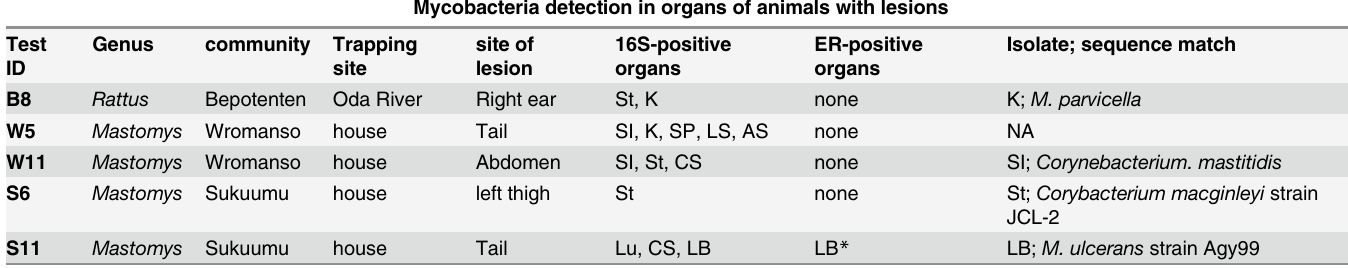
Table 4. Mycobacteria detection in organs of animals with lesions. Mycobacteria detection in organs of animals with